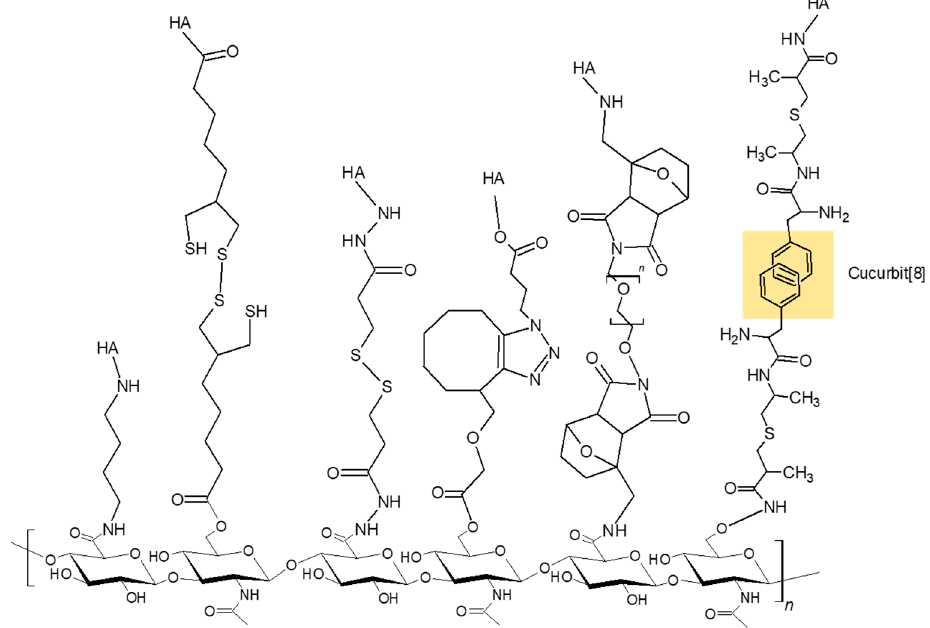
Figure 3. Chemical modification of hyaluronic acid to form hydrogels.